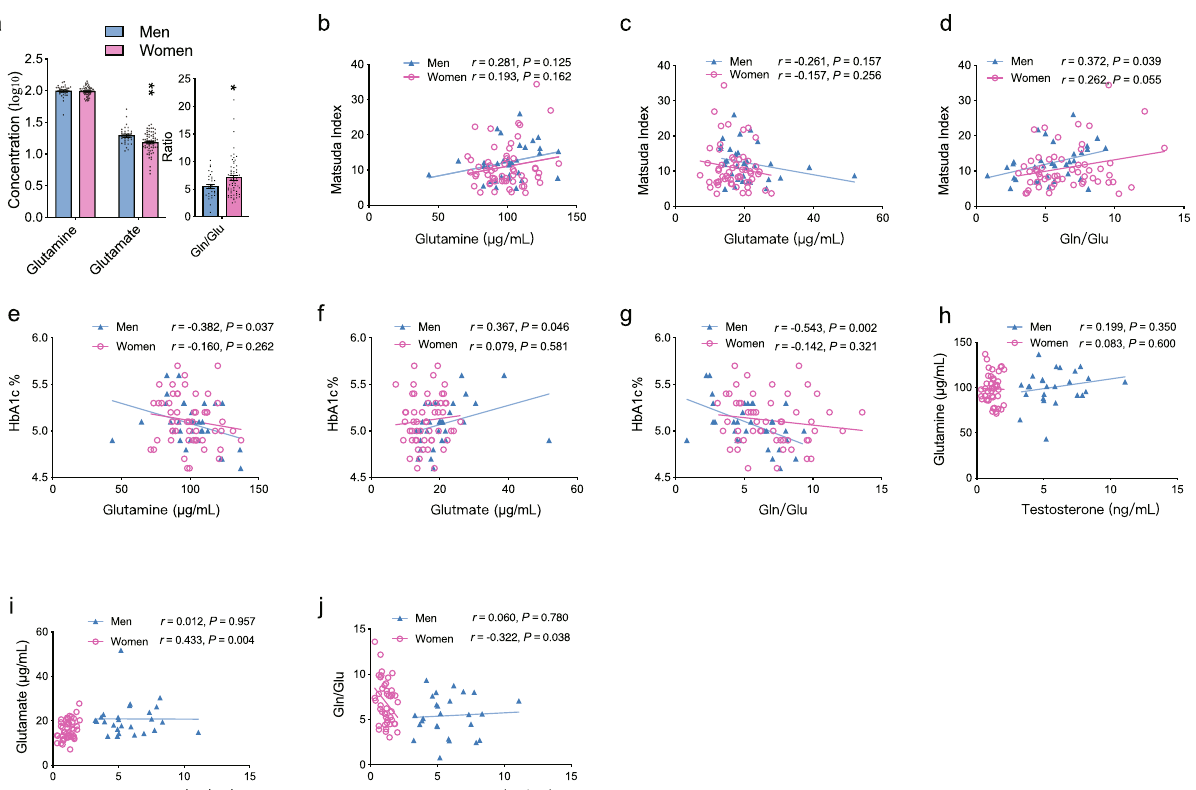
Fig. 6 Gln/Glu ratio is associated with insulin sensitivity and androgen in humans. a Serum concentrations of glutamine, glutamate, and Gln/Glu ratio in men ( n = 33) and women ( n = 63) (in glutamate, for men VS women, P = 0.001; in Gln/Glu, for men VS women, P = 0.021). The concentrations of glutamine and glutamate were calculated as log 10 and the ratio was calculated directly by the glutamine concentration to the glutamate concentration. b – j Partial correlation analysis of circulating glutamine, glutamate and Gln/Glu ratio with Matsuda index ( b – d ) (Men, n = 33; Women, n = 56), HbA1c ( e – g ) (Men, n = 32; Women, n = 53), and serum testosterone levels ( h – j ) (Men, n = 26; Women, n = 44) in men and women, respectively, adjusted for age and BMI. r and P value were based on the correlation in each sex. Each point represents a single sample. Blue points represent men and red points represent women. Gln/Glu, glutamine/glutamate. * P < 0.05, ** P < 0.01. Unpaired Student ’ s t-test (two-sided) was performed for Fig. 6 a . Data are expressed as mean ± SEM. Source data are provided as a Source Data fi